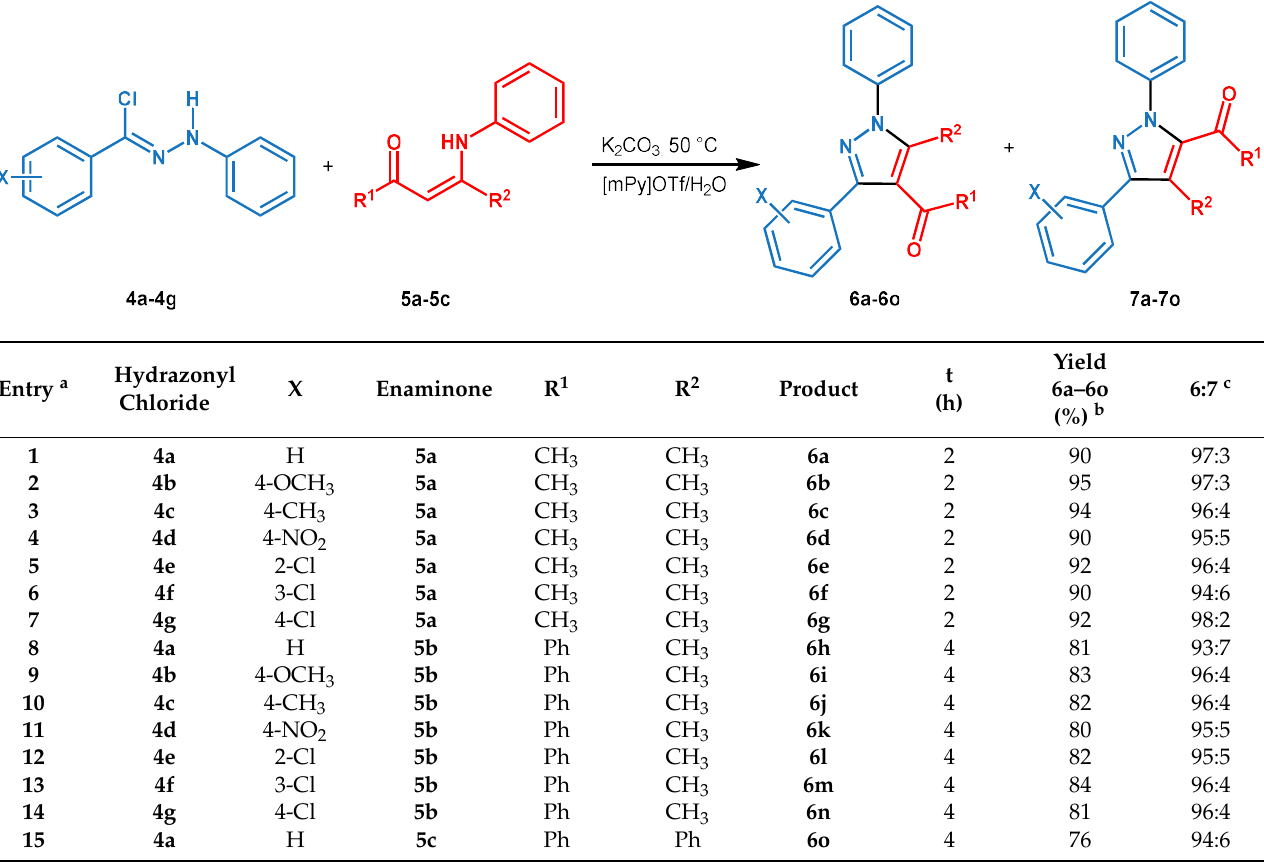
Table 2. Synthesis of 1,3,4,5-tetrasubstituted pyrazoles by eliminative 1,3-dipolar cycloaddition.